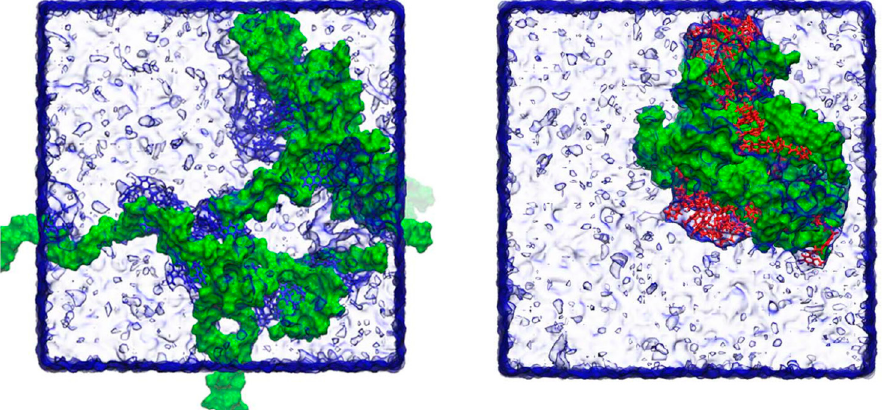
Figure 7. Snapshots of the final frame (at 100 ns) for the molecular dynamics simulations of inda- pamide ( left ) and glibenclamide ( right ) and HPMC at the low number of molecules. Indapamide molecules are indicated in blue, glibenclamide in red and HPMC in green, with surrounding water molecules rendered as a transparent surface. During the course of the simulations, individual drug molecules associate and disassociate from the polymer chains in both cases. Adapted with permission from Ref. [128]. 2023, Elsevier.